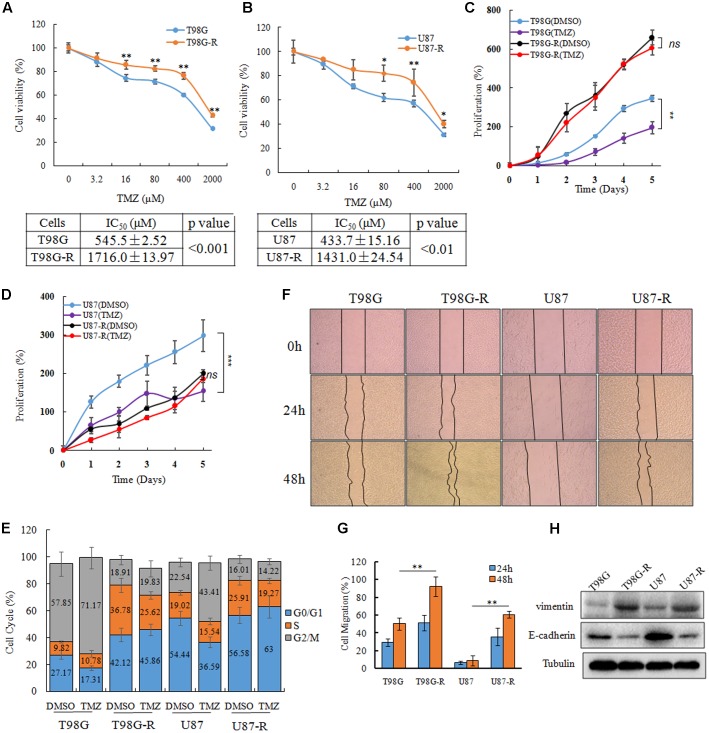
Establishment and characterization of TMZ-resistant GBM cell lines. (A,B) Cell viability analysis was performed to evaluate cytotoxicity of TMZ to T98G, T98G-R, U87, and U87-R cells under treatment with the indicated concentrations of TMZ for 72 h. (C,D)
In vitro cell proliferation curves in response to TMZ treatment. (E) GBM cells were treated with or without TMZ for 48 h and cell cycle was examined by flow cytometry. (F,G) GBM cells subjected to wound healing assays. Cell migration rate was analyzed by ImageJ. (H) Expression of E-cadherin and Vimentin in GBM cells was examined by western blot. Above experiments were repeated three independent times with similar results. Each data point represents the mean ± SD. ∗p < 0.05, ∗∗p < 0.01, and ∗∗∗p < 0.001.